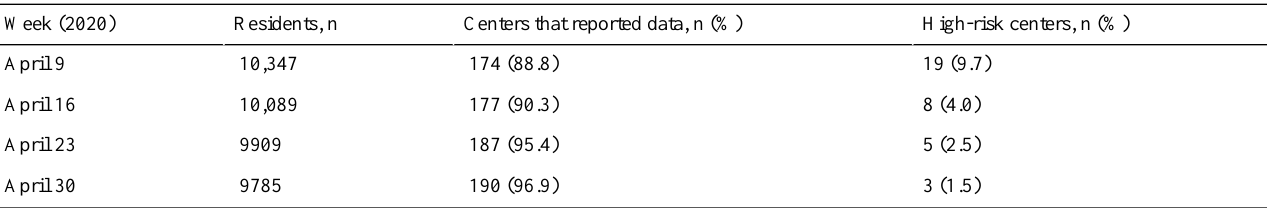
Table 1. Weekly data on the number of institutionalized residents, percentages of centers that reported data on the COVIDApp platform, and number of facilities considered to be high-risk.